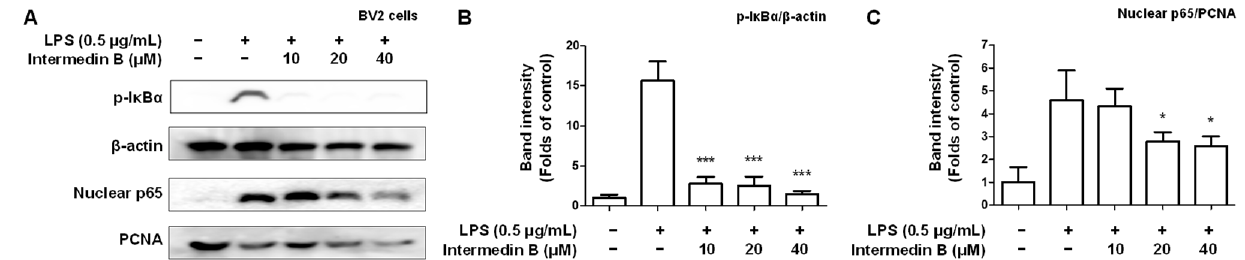
Figure 8. E ff ect of intermedin B ( 4 ) isolated from C. longa on inhibiting nuclear factor-kappa B (NF- κ B) p65 activation in LPS-induced BV2 microglia. To examine the inhibitory e ff ect of intermedin B ( 4 ) on the activation of NF- κ B p65 and p-I κ B α , cells were treated with LPS for 0.5 h following pretreatment with 10–40 µ M of intermedin B ( 4 ). ( A ) Western blotting was performed, and the immunoblot was quantified using ImageJ software to quantify the expression levels of p-I κ B α ( B ) and p65 ( C ). The intensities of the bands were normalized to those of β -actin and PCNA, and the data are presented as mean ± SD of 3 independent experiments. * p < 0.05, and *** p < 0.001 compared with LPS. We investigated whether intermedin B ( 4 ) showed an inhibitory effect on ROS gen- eration based on its results in suppressing oxidative stress in glutamate-induced HT22 hippocampal cells. These results confirm that intermedin B ( 4 ) inhibited ROS generation in a concentration-dependent manner (Figure